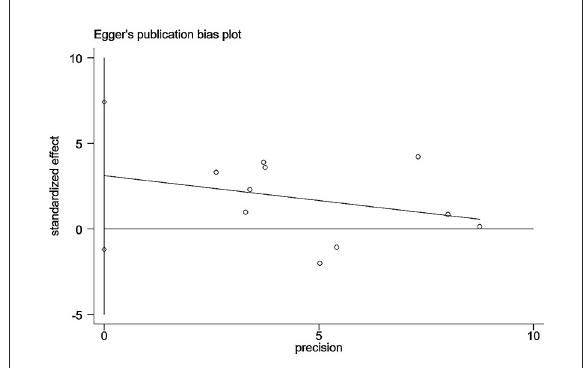
FIGURE12 Publication bias test for the overall effect test of BMD LS change.